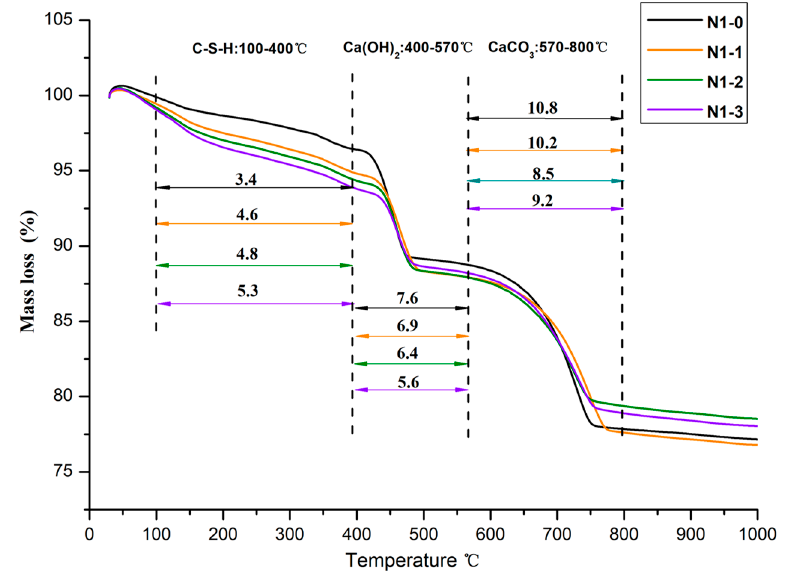
Figure 12. TG curves of the group N1. Table 4. The content of the main phases in samples with various concentrations of LS (%). Group Samples Water Bound to